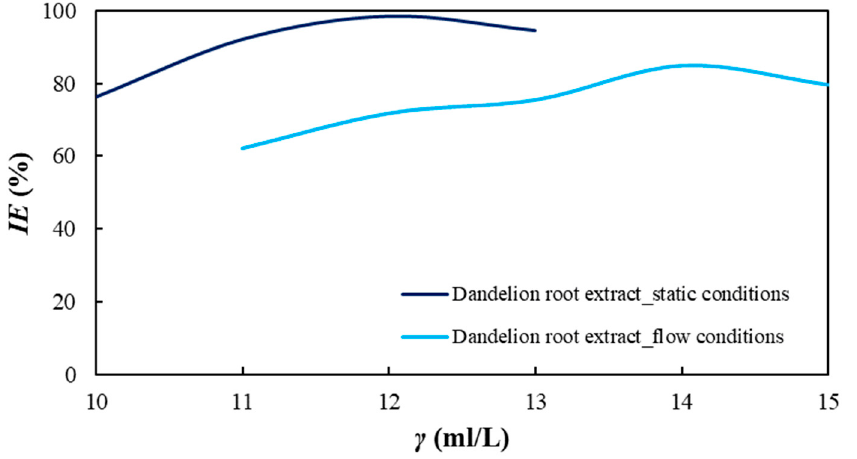
Figure 9. The inhibitor efficiency comparison determined from polarization curves scanned on the carbon-steel sample in the simulated brine saturated with CO 2 (Adapted from [24]).